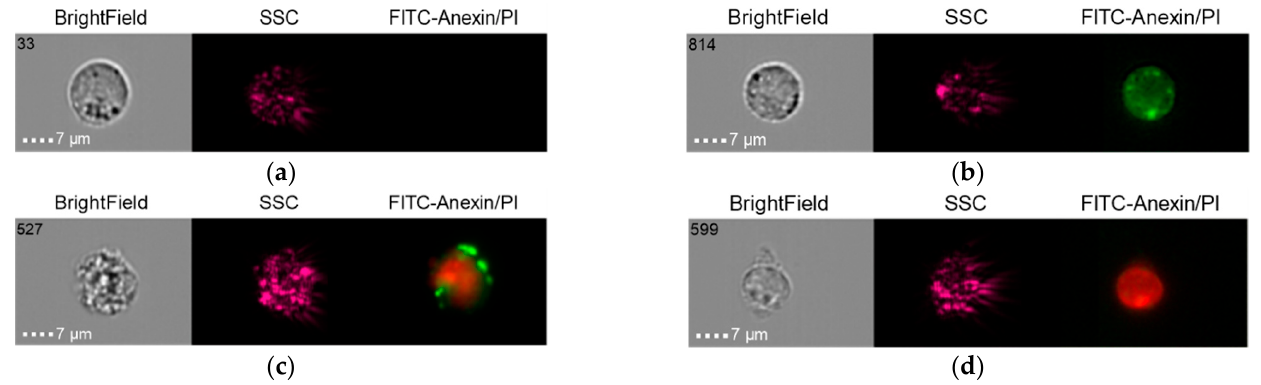
( d ) Figure 9. Live cells ( a ), early apoptosis ( b ), late apoptosis ( c ), necrosis ( d ) after co-culture of Nobel